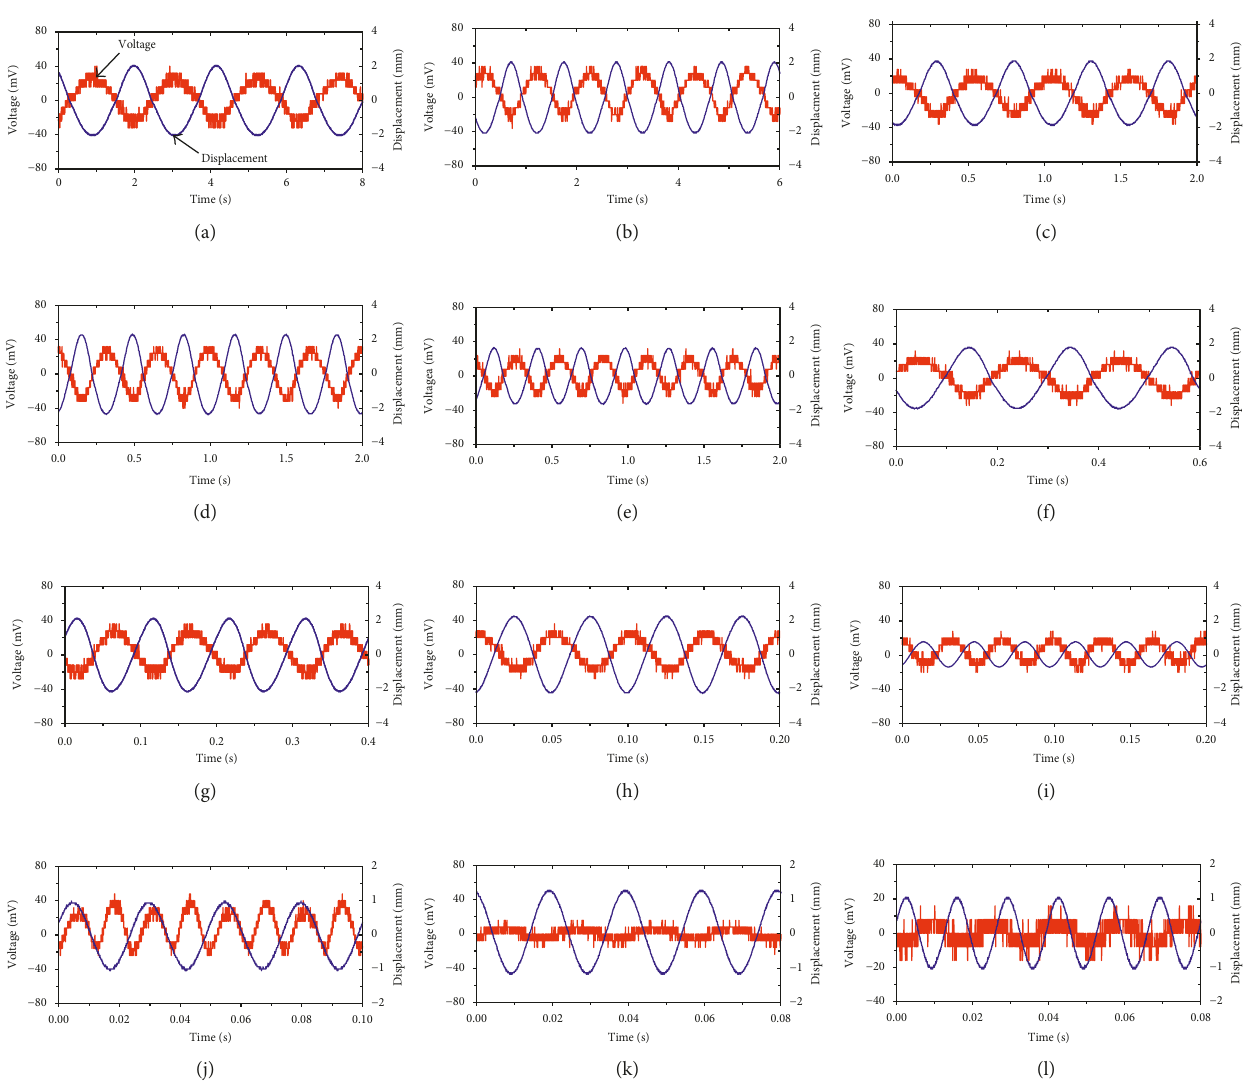
Figure 5: Dynamic response of magnetostrictive whisker sensor at exciting frequency of (a) 0.5, (b) 1, (c) 2, (d) 3, (e) 3.5, (f) 5, (g) 10, (h) 20, (i) 30, (j) 40, (k) 50, and (l)